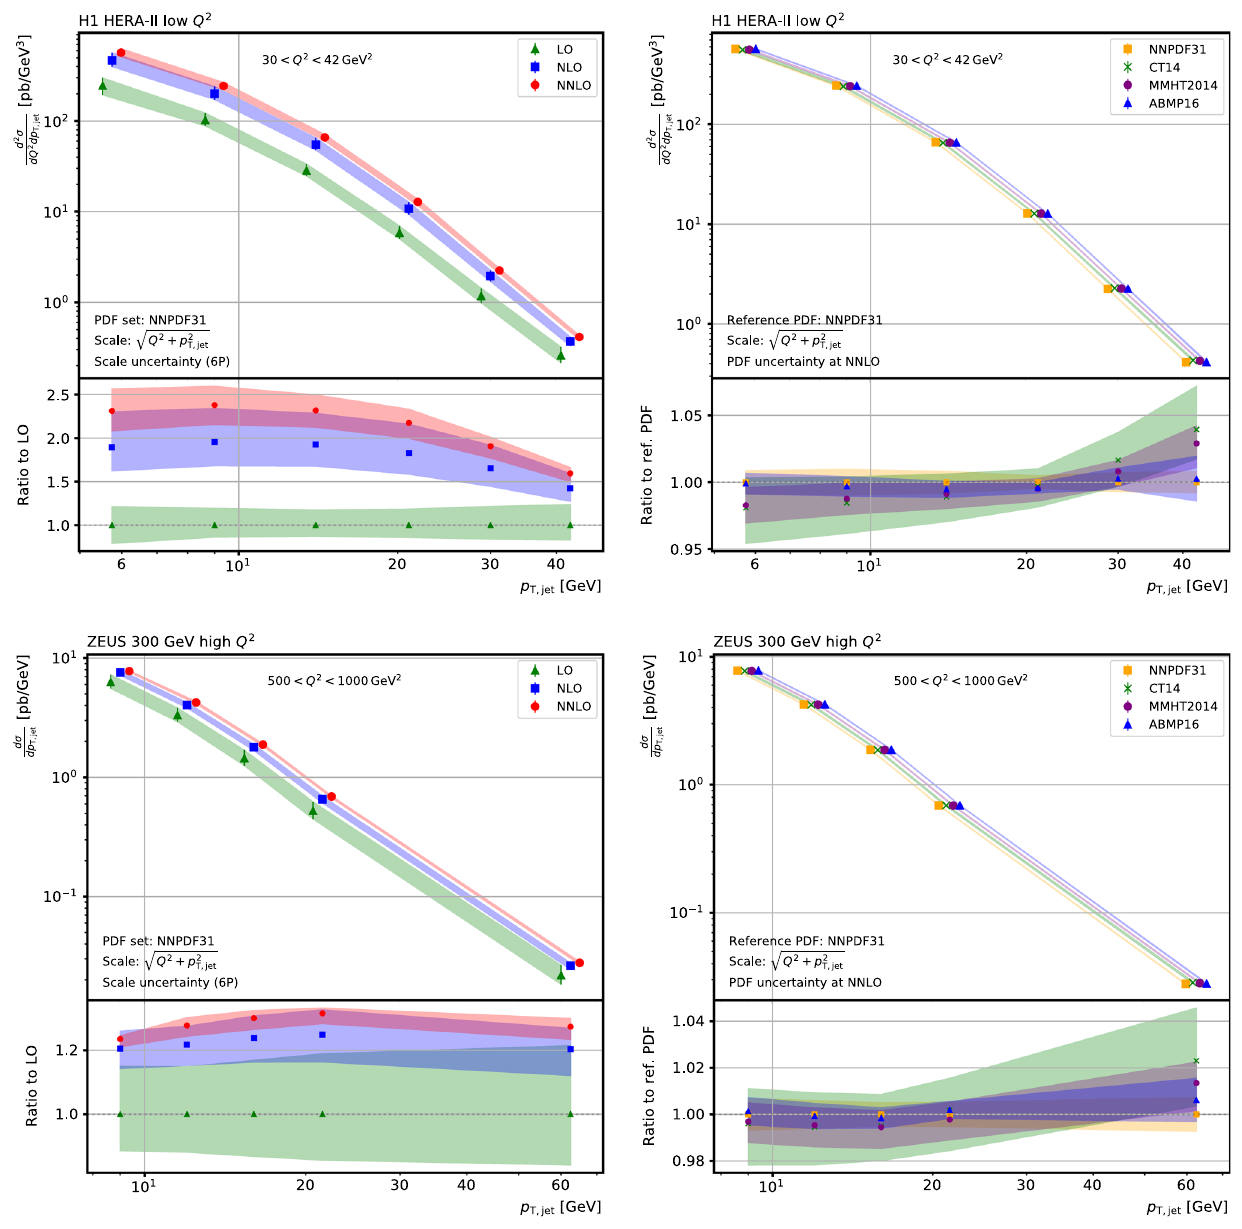
Fig. 4 Inclusive jet cross section as a function of the jet p T for two ranges in Q 2 : 30 < Q 2 < 42GeV 2 for H1 data (upper row), and 500 < Q 2 < 1000GeV 2 for ZEUS data (lower row). On the left the LO, NLO, and NNLO predictions are shown using the NNPDF31 PDF set including their ratio to the LO in the respective lower panels. On the right the NNLO predictions are shown for the four PDF sets